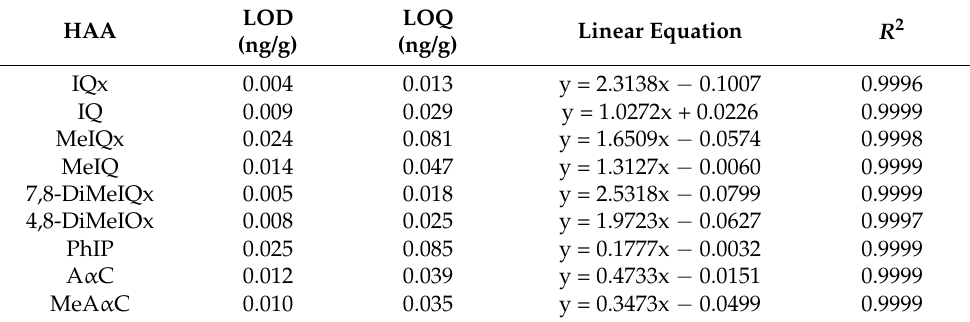
Table 3. The limits of detection (LOD) and quantitation (LOQ), linear equation, and regression coefficients ( R 2 ) for different heterocyclic aromatic